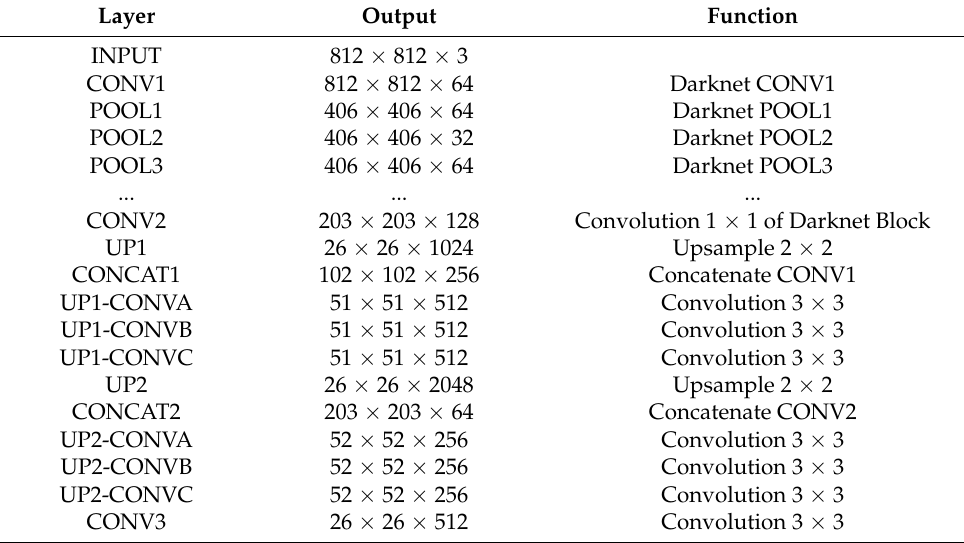
Table 2. Final network architecture used: Layers up to CONV2 are provided by CSP Darknet-53 [22]. Each convolutional layer is supported by the Mish activation function, which outperformed Leaky ReLU on the CSPDarknet-53 backbone [34]. Notice the feature pyramid net concatenating to form a 26 × 26 × 2048 volume on the second upscaling.